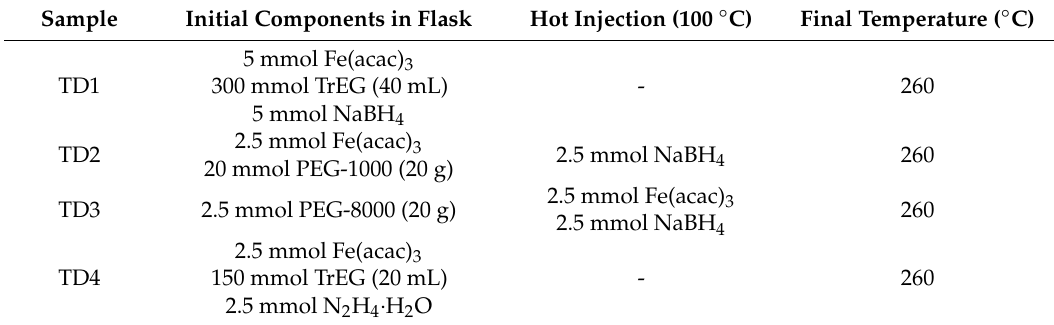
Table 1. Synthetic protocols of the thermal decomposition samples